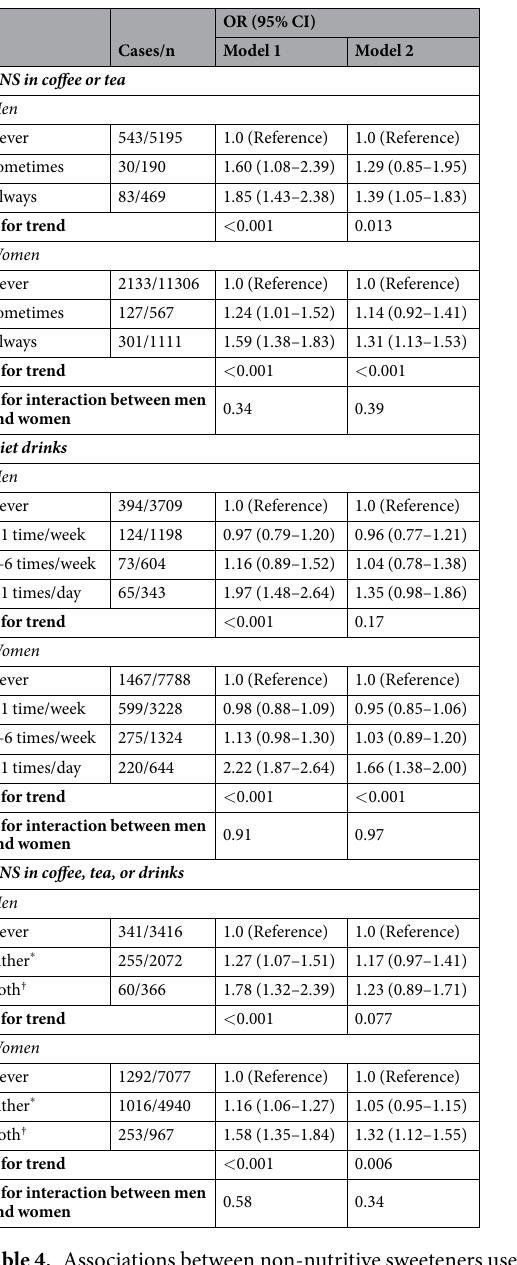
associations. We assessed NNS use as frequencies of daily intake but not the amount; this might compromise the strength of the observed associations as well. The associations of heavy coffee drinking and NNS use with depres- sion were more apparent among women than men. This finding might be due to that the sample size of male participants was smaller than females and men had significantly lower prevalence of depression than women. The P values for interactions between men and women were not statistically significant indicating that men and women had similar trends in these associations. Finally, the cross-sectional nature of the study means we cannot infer causation from these results. In summary, our findings suggested that depressive symptoms, coffee drinking, and NNS use were corre- lated among populations in Atlantic Canada. Participants who reported heavy coffee drinking and NNS use had increased likelihoods for major depression compared with those who never drank coffee or consumed NNS.